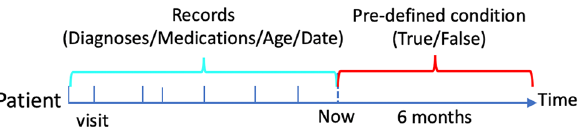
Figure 1. Illustration of prediction tasks. The axis represents time; medical records before ’now’ are used to predict the incidence of a condition in the following six months; the medical records include multiple visits, and each visit has one or more diagnoses and medications; the interval between two visits represents the time duration between